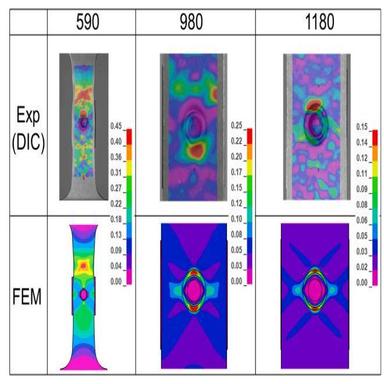
Comparision of y-strain between DIC and FEM analysis immediately before fracture generation.